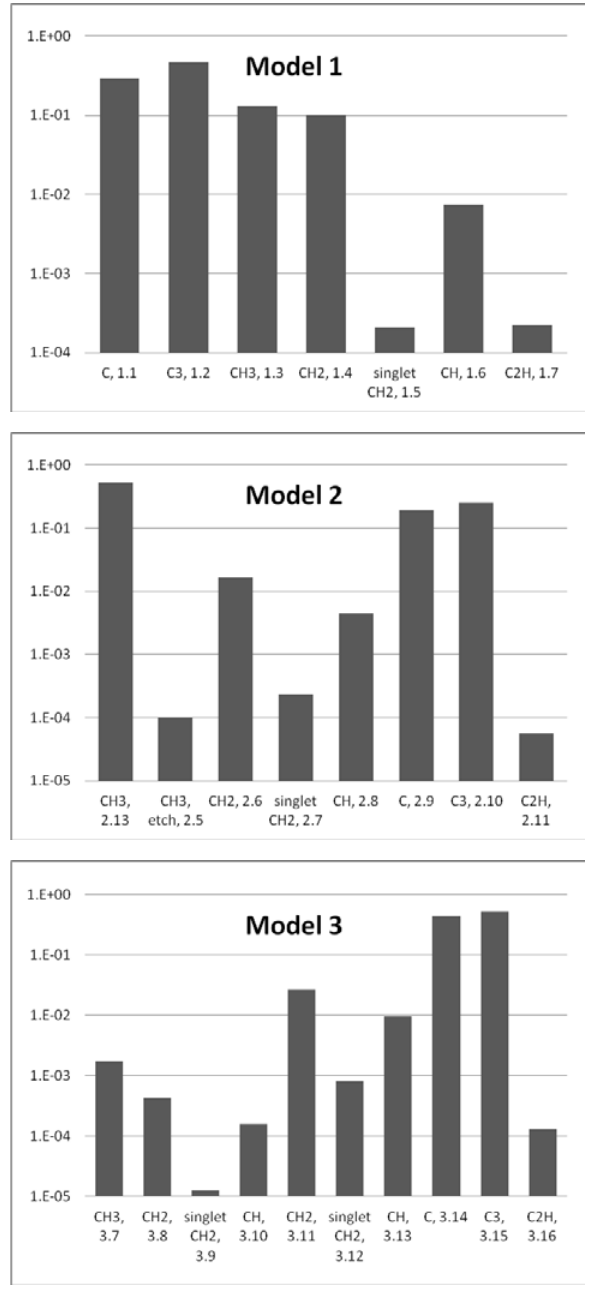
Figure 6. Diagrams of the contribution of different species to the growth rate for three considered models (logarithmic scale). Since contribution of the etching reaction 2.5 has the negative sign, here it is shown with an opposite sign. Under columns corresponding species and reactions are mentioned.